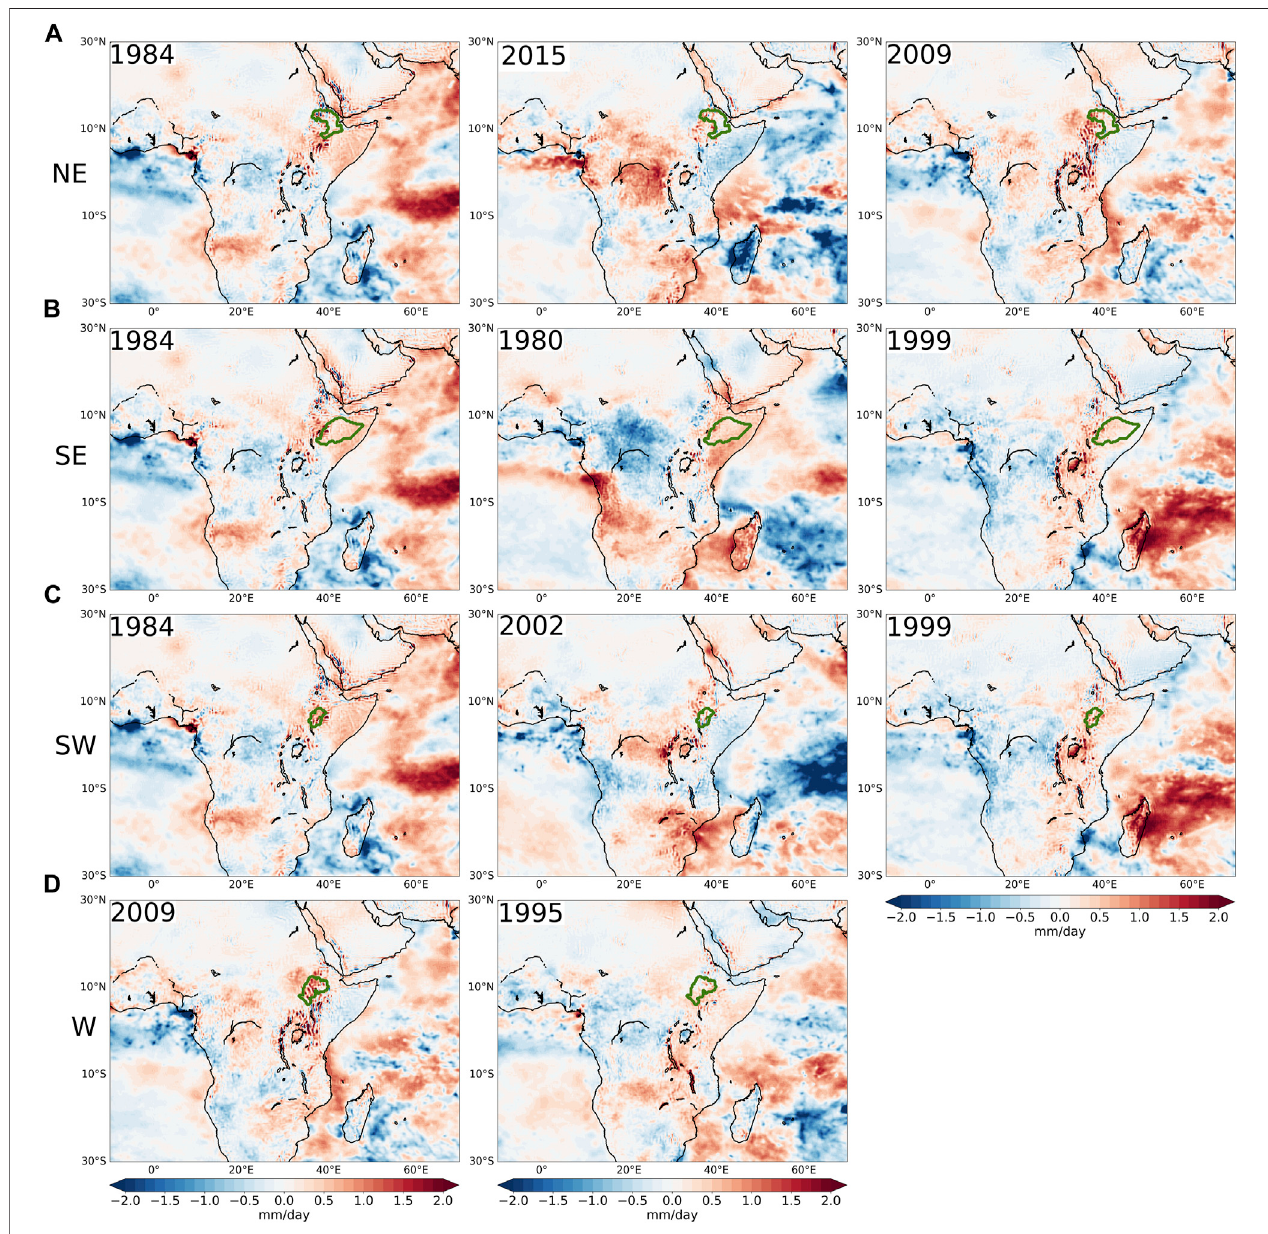
FIGURE 10 | Anomalies of vertically integrated moisture fl ux (VIMF, unit: mm/day) for severe annual drought in each of the four [NE (A) , SE (B) , SW (C) , and W (D) ] regions of study (shown in Figure 2 ).